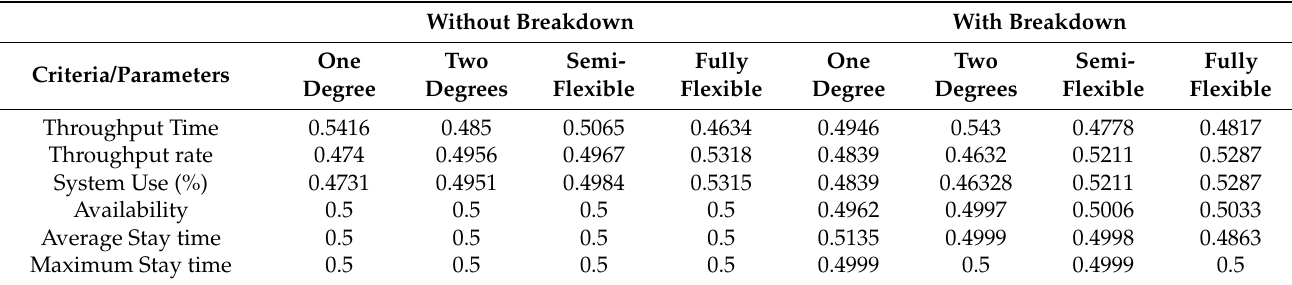
Table 12. Normalized Matrix of the collected values.